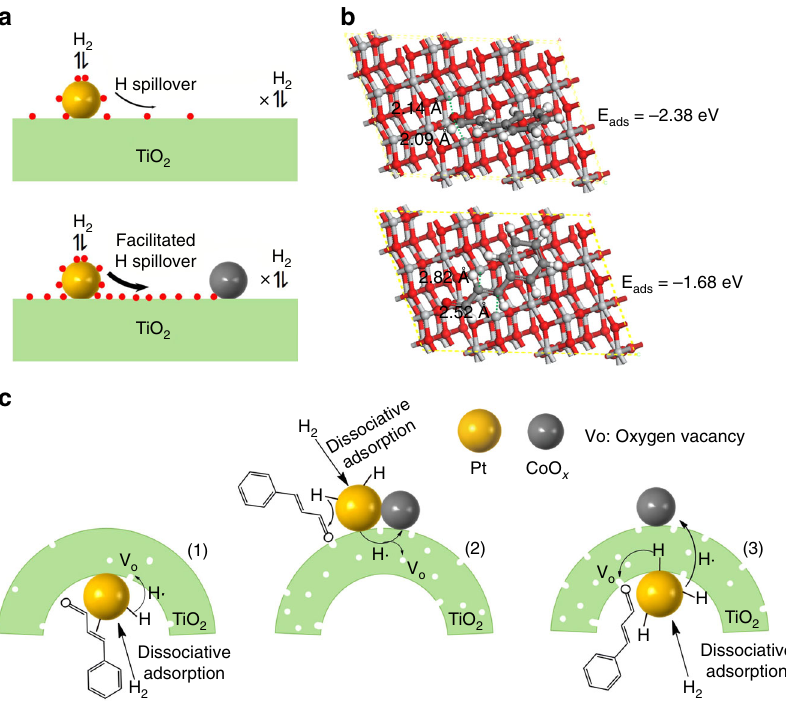
Fig. 5 DFT calculation and proposed reaction mechanisms. a The effect mechanism of CoO x on the hydrogen spillover over TiO 2 -supported Pt catalysts. b The optimized structure for adsorption of CALD molecule using C = O (top) or C = C (bottom) double bond on the O v of TiO 2 . Atom coloring: Ti, gray; O, red; H, white; C, black. c The possible enhancement mechanism for selective CALD hydrogenation reaction. (1), (2) and (3) represent TiO 2 /Pt, CoO x Pt/TiO 2 and CoO x /TiO 2 /Pt catalysts, respectively. For TiO 2 /Pt, the number of O v is limited, leading to its low selectivity. For CoO x Pt/TiO 2 and CoO x /TiO 2 /Pt, the addition of CoO x promotes the formation of O v sites through hydrogen spillover and thus improves the selectivity, regardless of whether CoO x and Pt are separated by a TiO 2 layer or